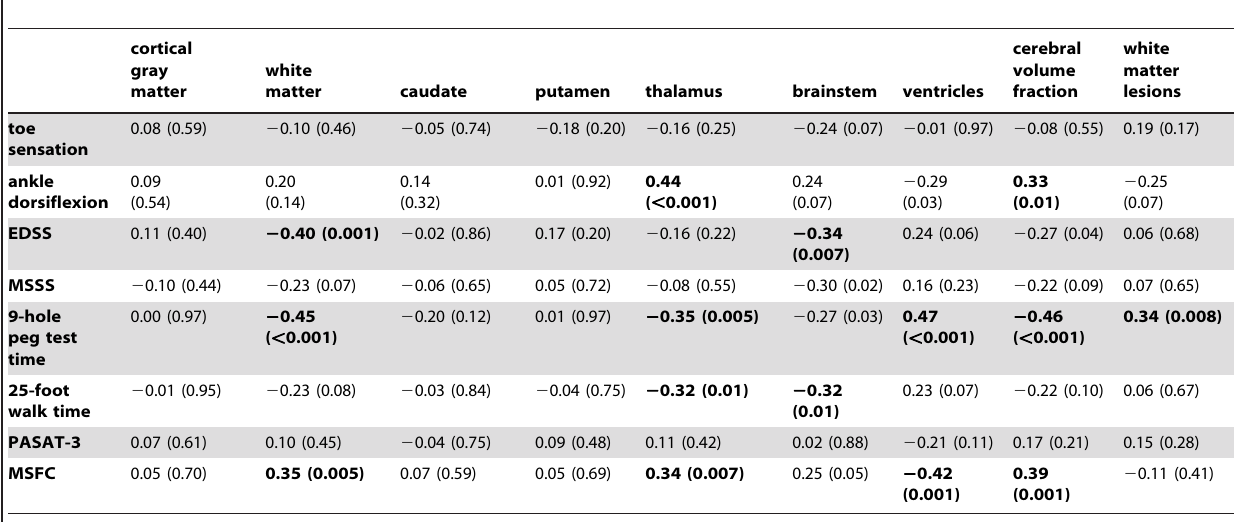
Table 4. Partial correlations of impairment measures with normalized structure